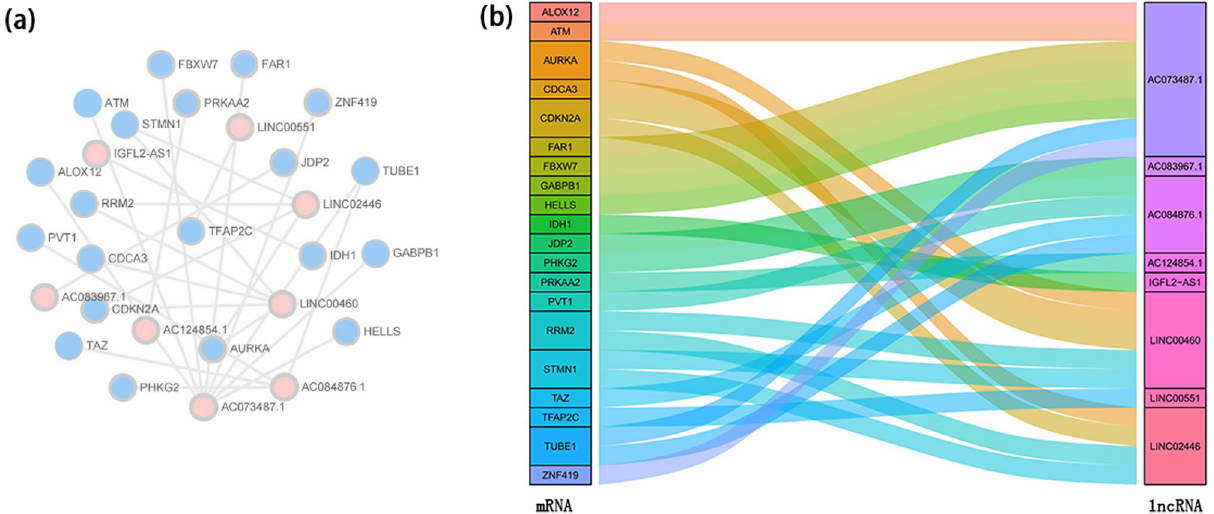
Figure 6. Construction of a co-expression network. ( a ) The co-expression network of 8 FALs and 20 FAGs. ( b ) The Sankey diagram manifested how 8 FALs and 20 FAGs were connected.